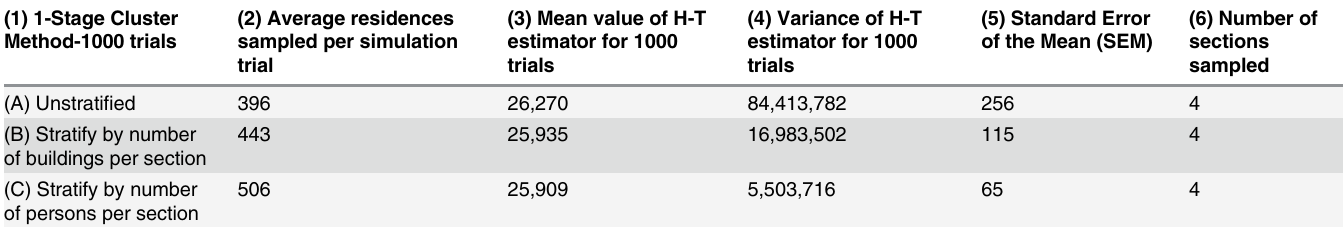
Comparison of the standard deviation σ , the variance σ 2 , and the SEM ( Standard Error of the Mean ) for the single-stage sampling protocol. The uncertainty of the Horvitz-Thompson population estimate decreases as a function of the protocol used to partition the 20 sections of Bo City into 4 strata: There are 1,979 residential structures in the 20 sections, and a measured population of 25,954